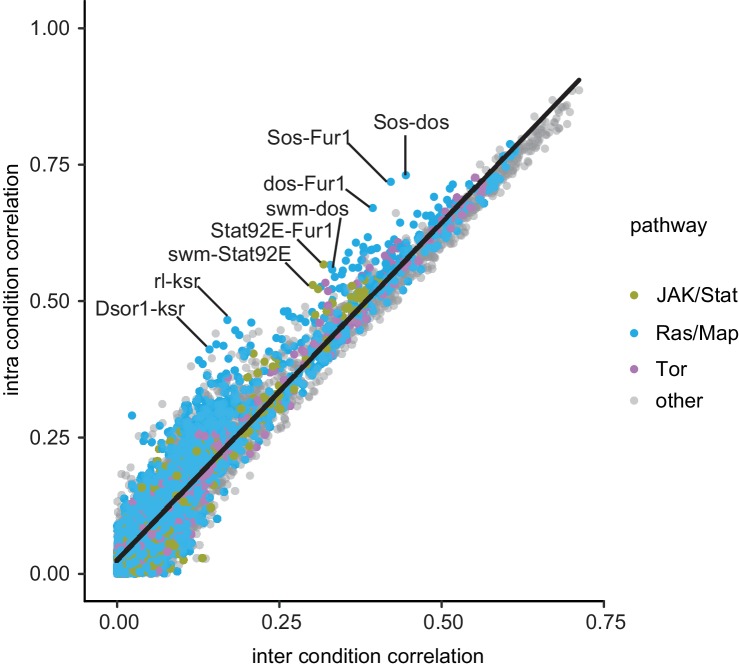
Differential correlation analysis reveals that Fur1 and swm rewire coherently to Ras signaling components.Interaction profiles of all target genes interacting with all query genes amongst all features and time points were analyzed for their pairwise Pearson correlation coefficient within and between treatment conditions. Non-significant interaction (FDR > 10%) were set to 0, such that they do not contribute to the correlation. A linear regression shows the expected average dependency of intra and inter condition profile correlation. Deviations from this expectation mark interaction profiles highly dependent on Dsor1 (Billmann and Boutros, 2017).